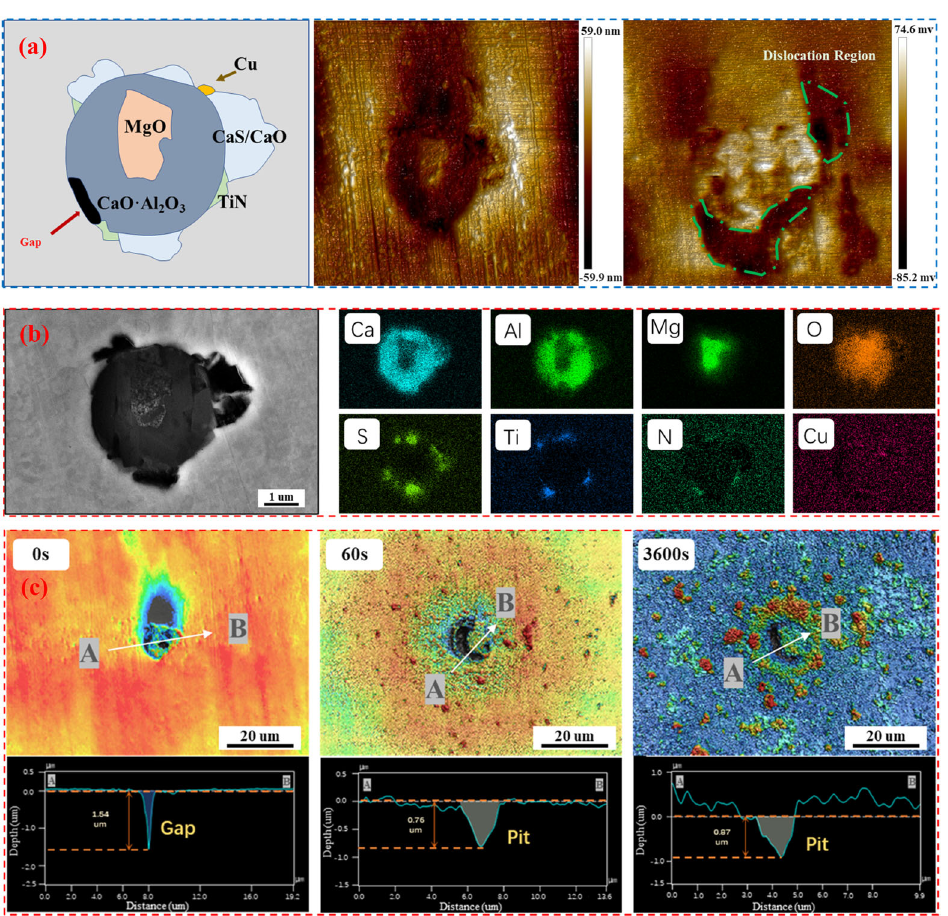
Fig. 12 The characteristics and in-situ corrosion behavior of CaS/CaO – MgO – Al 2 O 3 Cu-containing inclusion. a SKPFM analysis of the CaS/ CaO – MgO – Al 2 O 3 inclusion. b EDS analysis of the CaS/CaO – MgO – Al 2 O 3 inclusion. c Corrosion morphology of the CaS/CaO – MgO – Al 2 O 3 inclusion after different times of immersion.